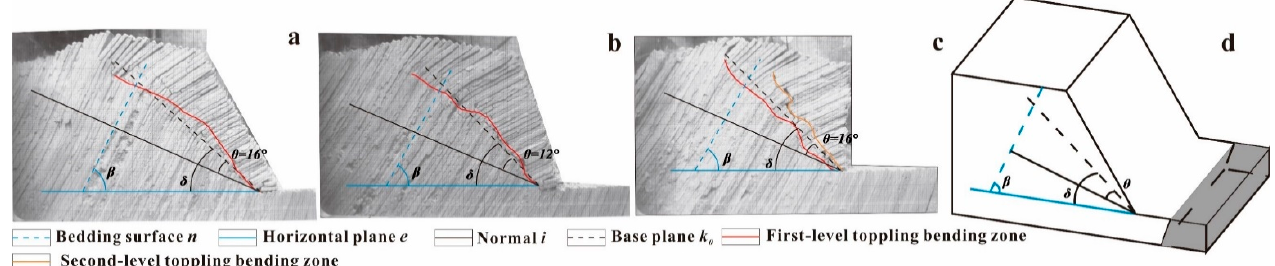
Figure 12. Developmental characteristics of the toppling bending zone, ( a ) 55° slope, ( b ) 65° slope, ( c ) 75° slope, ( d ) 3D schematics. ( c ) 75 ◦ slope, ( d ) 3D